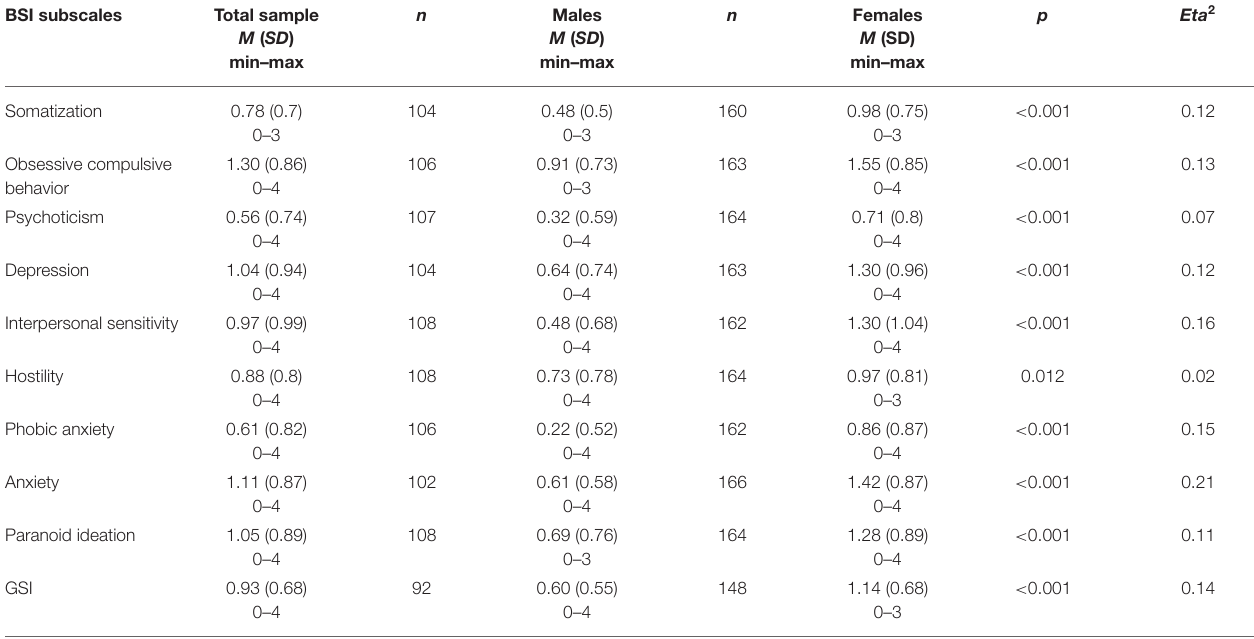
TABLE 1 | Self-reported psychiatric problems in the general population of a sample of Swedish adolescents ( N = 286). BSI